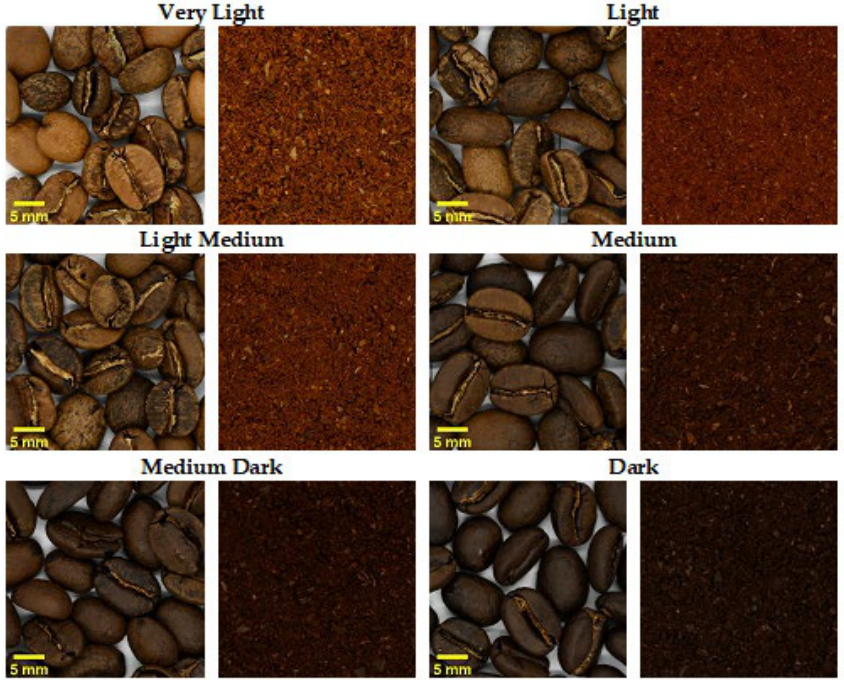
Figure 5. Illustration of coffee bean roast color demonstrating the color of the beans and grounds at different roast levels.